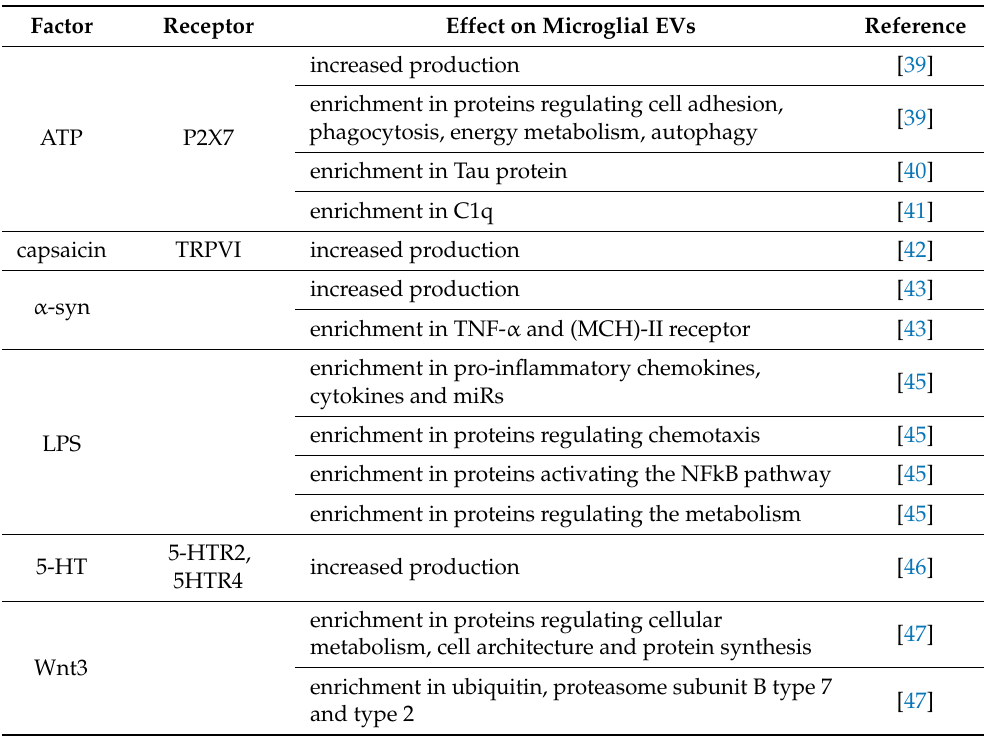
Table 1. Modulating factors, specific receptors, and effects on microglial